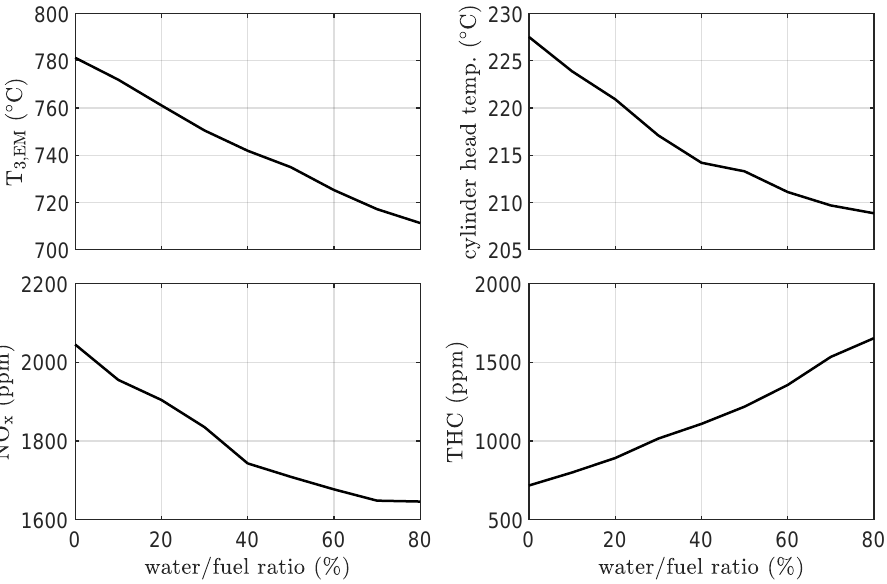
Figure 10. Effects of water injection on the relevant temperatures and engine-out emissions at an engine speed of 3000 rpm and a brake torque of 300